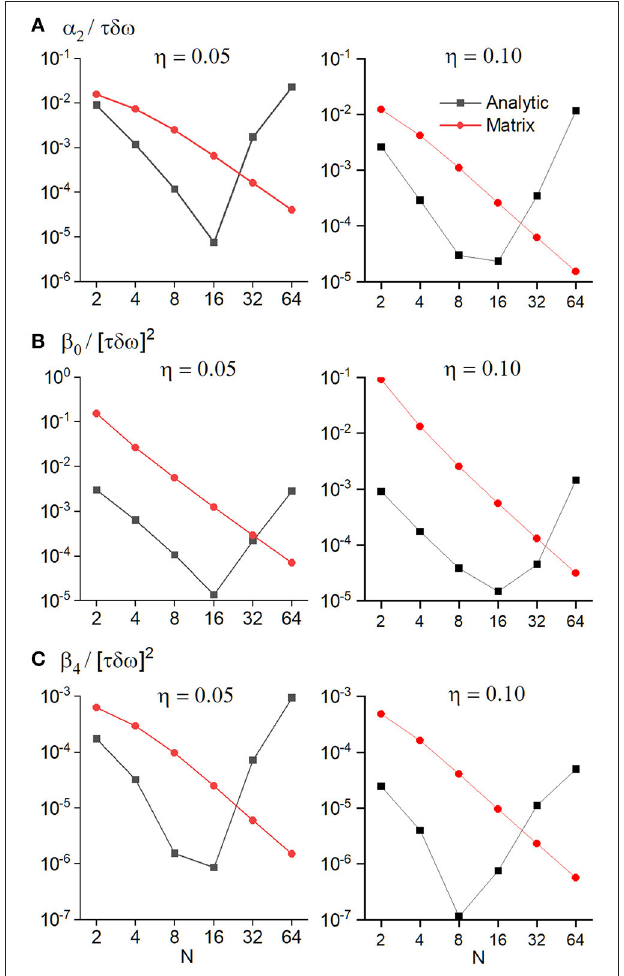
FIGURE 4 | Real and imaginary parts of the local magnetization calculated from the GLP first order according to Equation (80) (black solid line), GLP second order according to Equation (81) (red solid line) or with a finite element simulation of the Bloch-Torrey equation (blue solid line) at the discretized radial R D ] / 2 (B) , and R D (C) for φ points R C (A) , R M [ R C 0, τδω 10 = + = = and η =